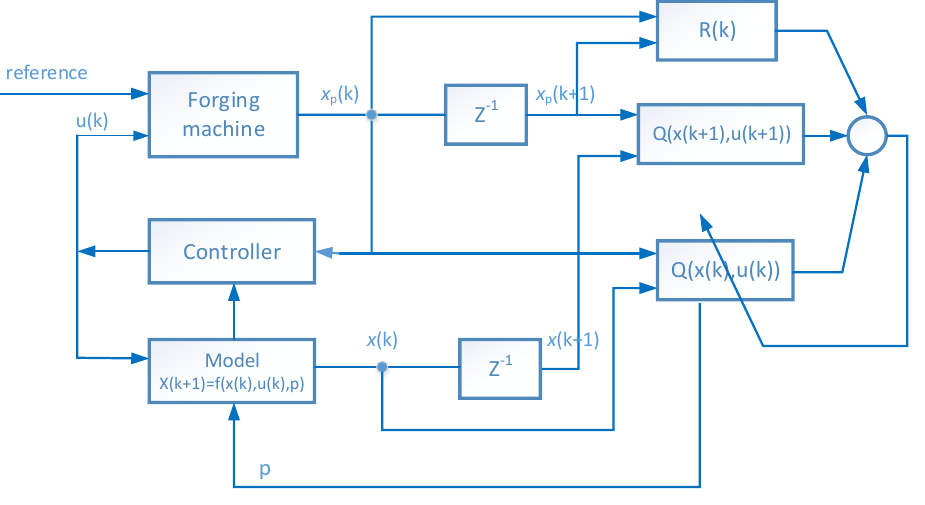
Figure 3. The scheme of proposed approach.